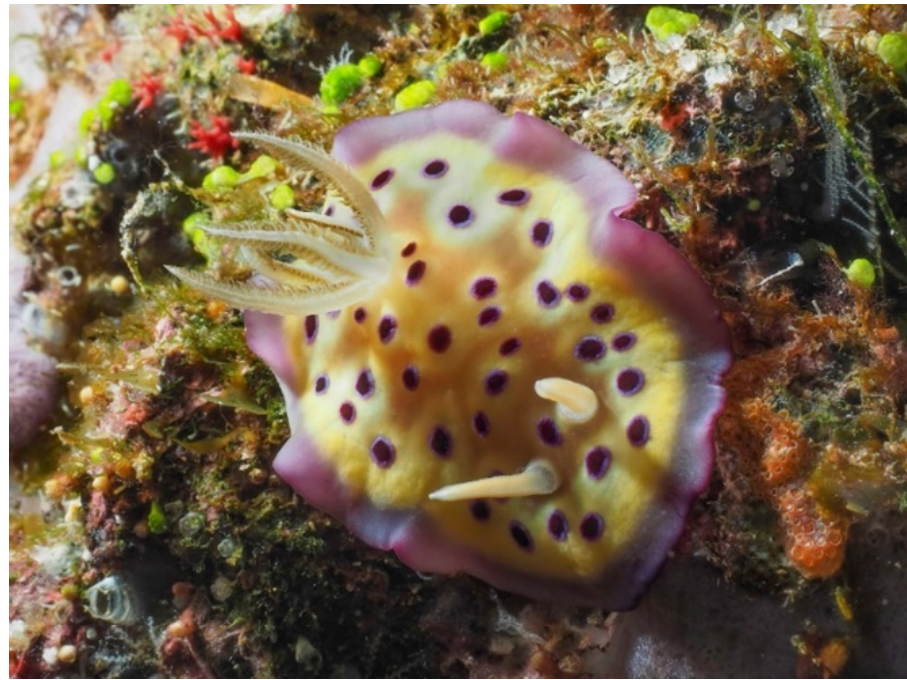
Figure 6. Goniobranchus kuniei , South West Solitary Island, NSW, 23 January 2022. Photo: N. Fripp. Goniobranchus rufomaculatus (Pease, 1871)